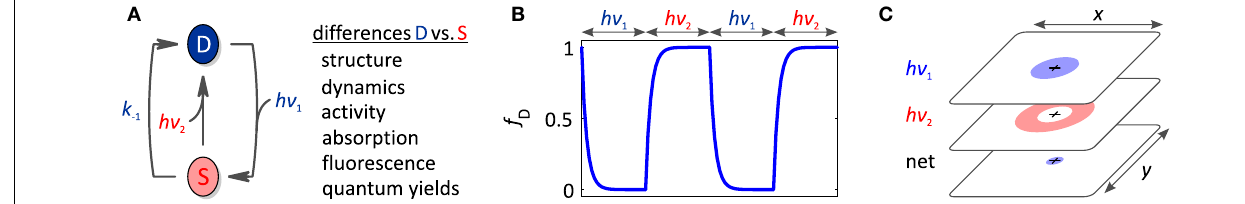
to reversibly toggle these properties. (B) Light-driven, bidirectional interconversion enables better time resolution than for non-photochromic photoreceptors. (C) Likewise, superior local control is achievable by spatially interleaving different light colors. A setup akin to STED super-resolution microscopy might be implemented to achieve photoreceptor stimulation volumes with supreme spatial